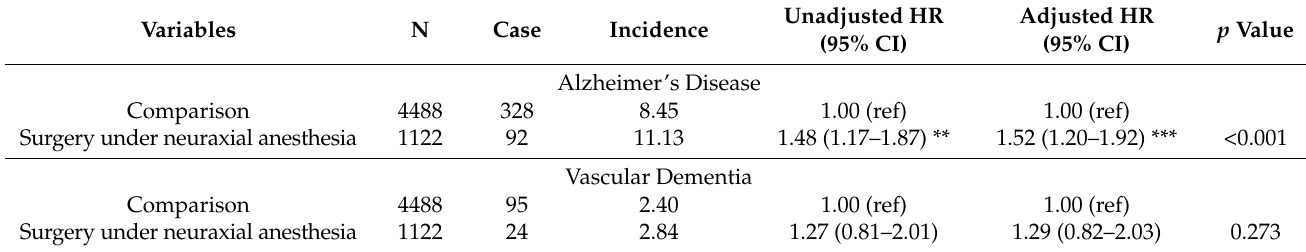
Table 4. Incidence per 1000 person-years and HR (95% CI) of specific diseases (Alzheimer’s disease and vascular